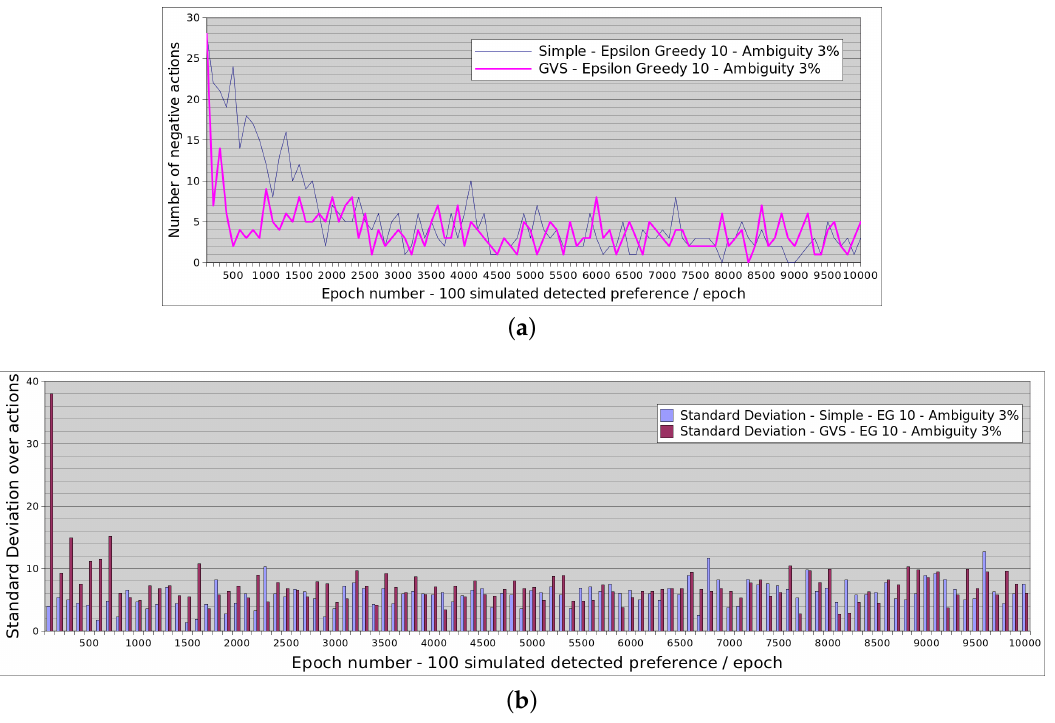
Figure 6. Simulated results comparing the GVS algorithm with a simple method using an epsilon greedy mechanism with (cid:101) = 10 in the action selection process and with an ambiguity of 3% in users feedback. ( a ) the number of negative actions in each epoch; ( b ) the standard deviation between the number of times each action was used during an